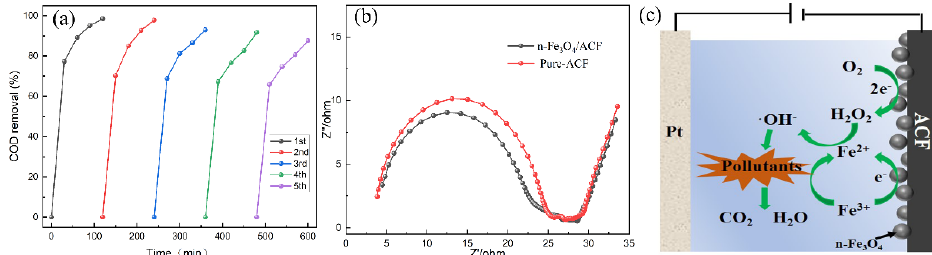
Figure 5. ( a ) The degradation reversibility of n-Fe 3 O 4 /ACF; ( b ) electrochemical AC impedance spec- tra of Pure-ACF and n-Fe 3 O 4 /ACF; ( c ) schematic degradation mechanism diagram of n-Fe 3 O 4